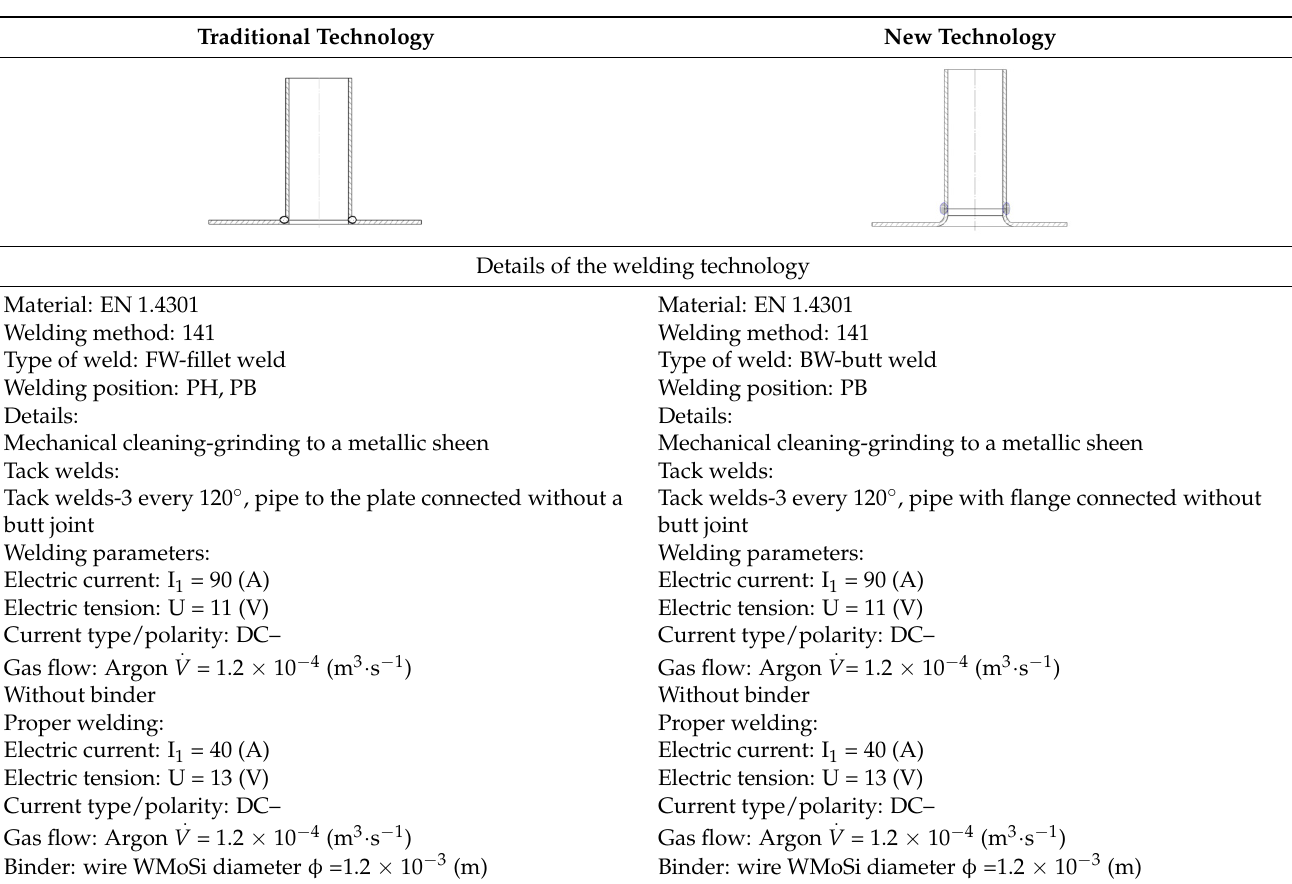
Table 4. Welding parameters.